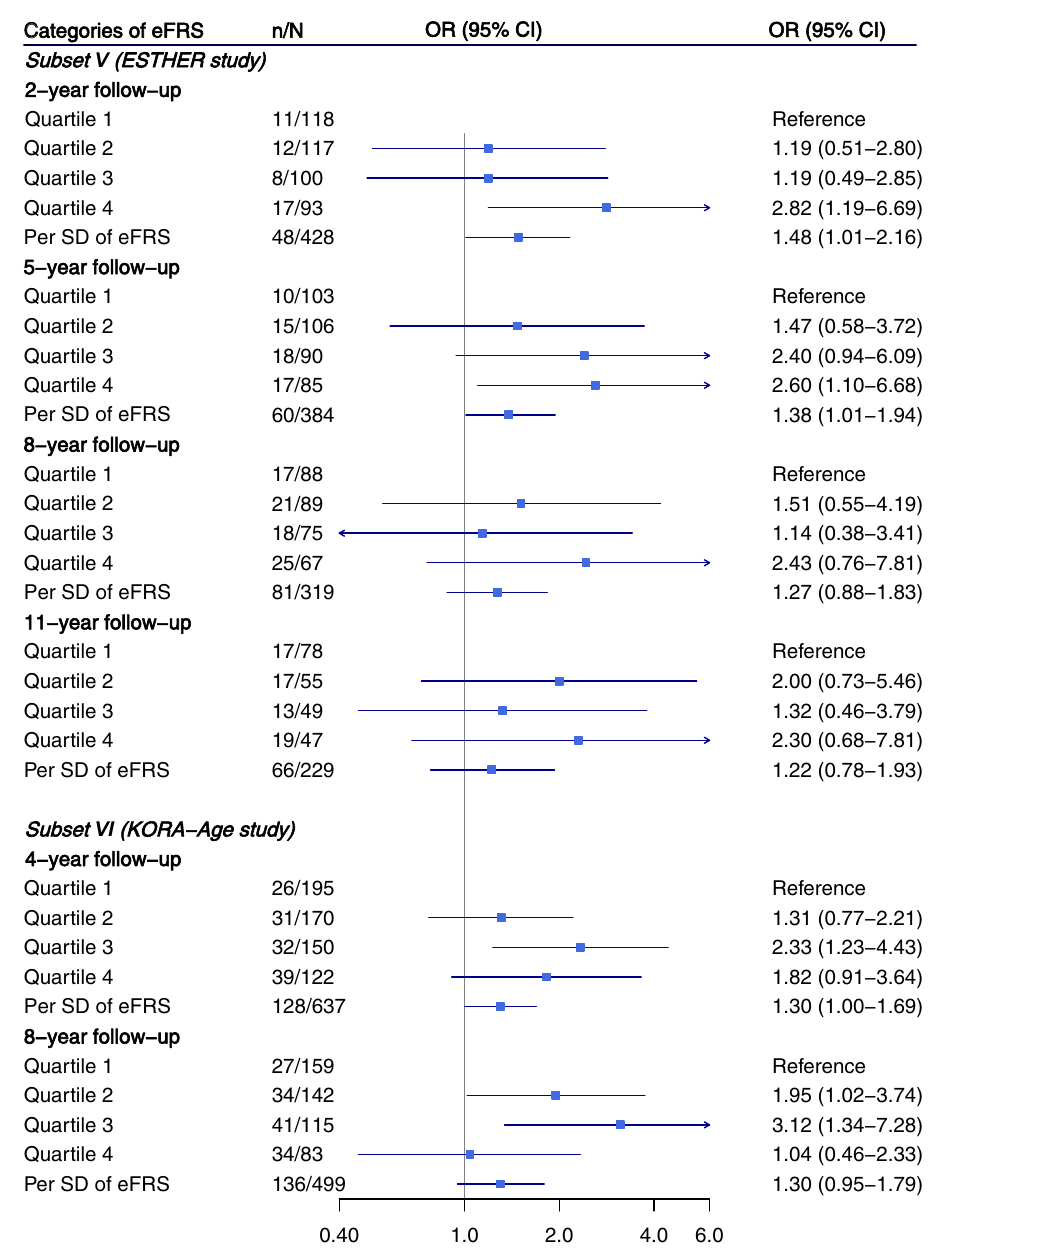
Fig. 3 | Association of epigenetic frailty risk score with being frail among par- ticipants who were being non-frail or pre-frail at baseline. Vertical ticks within theblue boxesand horizontallinesshowthe OR and 95%CI.Modelswereadjusted forage,sex,leukocytecomposition,batch,baselinesmokingstatus(neversmoker,